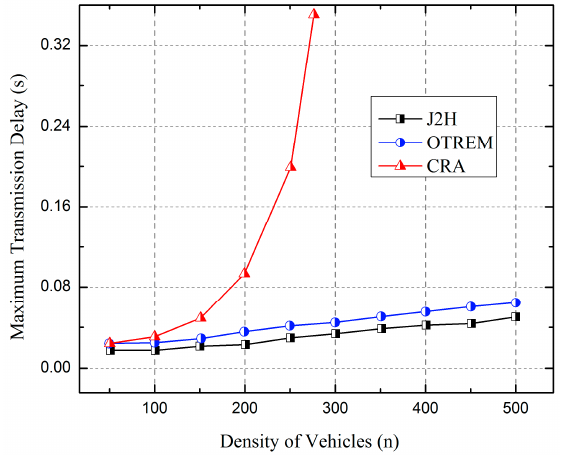
Figure 8. Analysis of maximum transmission delay in transmitting alert messages with high density of vehicles.